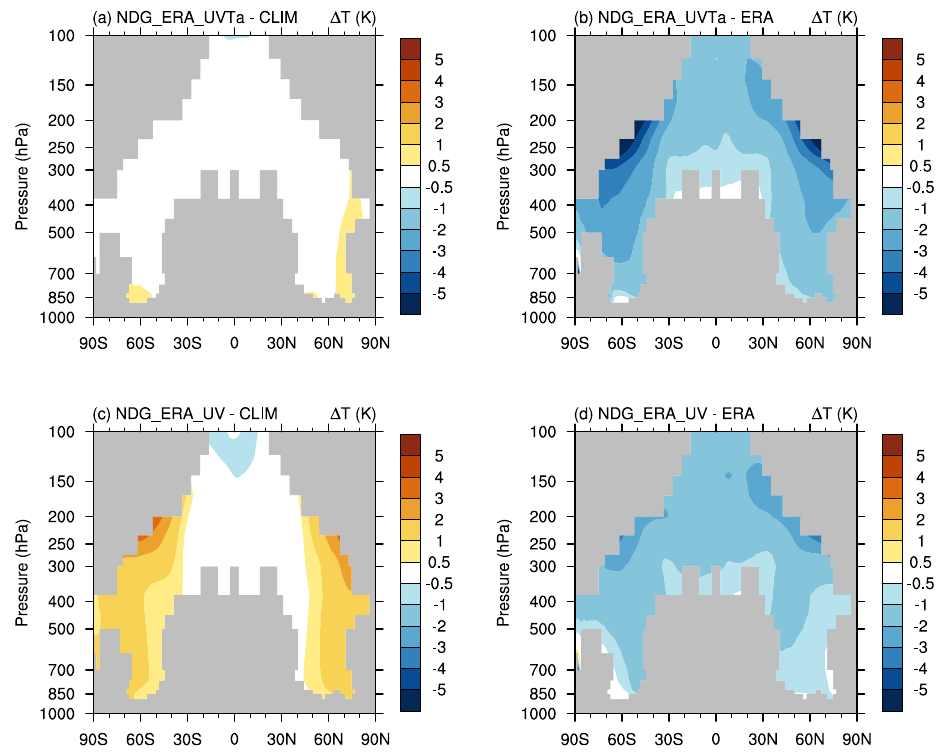
Figure 7. Left column: 5yr (2006–2010) mean zonally averaged temperature differences between nudged and free-running CAM5 simulations. Right column: same as left column but between nudged CAM5 simulations and the ERA-Interim reanalysis. Simulations shown in the upper and lower rows used the anomaly nudging described in Sect. 2.2 (NDG_ERA_UVTa) and the wind-only nudging (NDG_ERA_UV), respectively. Like in Fig. 3, regions with mean ice crystal number concentration lower than 5 g − 1 are masked out in gray.